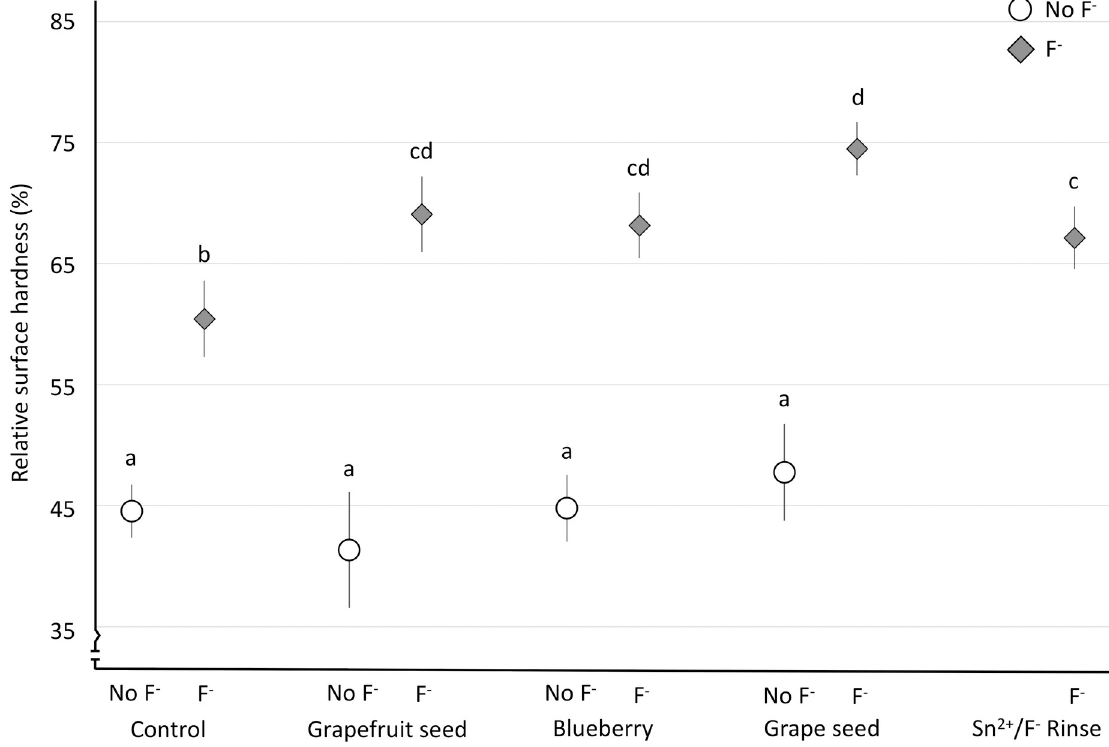
Fig 1. Mean relative surface microhardness (rSH) and standard deviation (error bars), according to the solutions. Groups with different letters are significantly different from each other. Different shaded symbols mean presence (gray diamonds–F - ) or absence (white circles–No_F - ) of